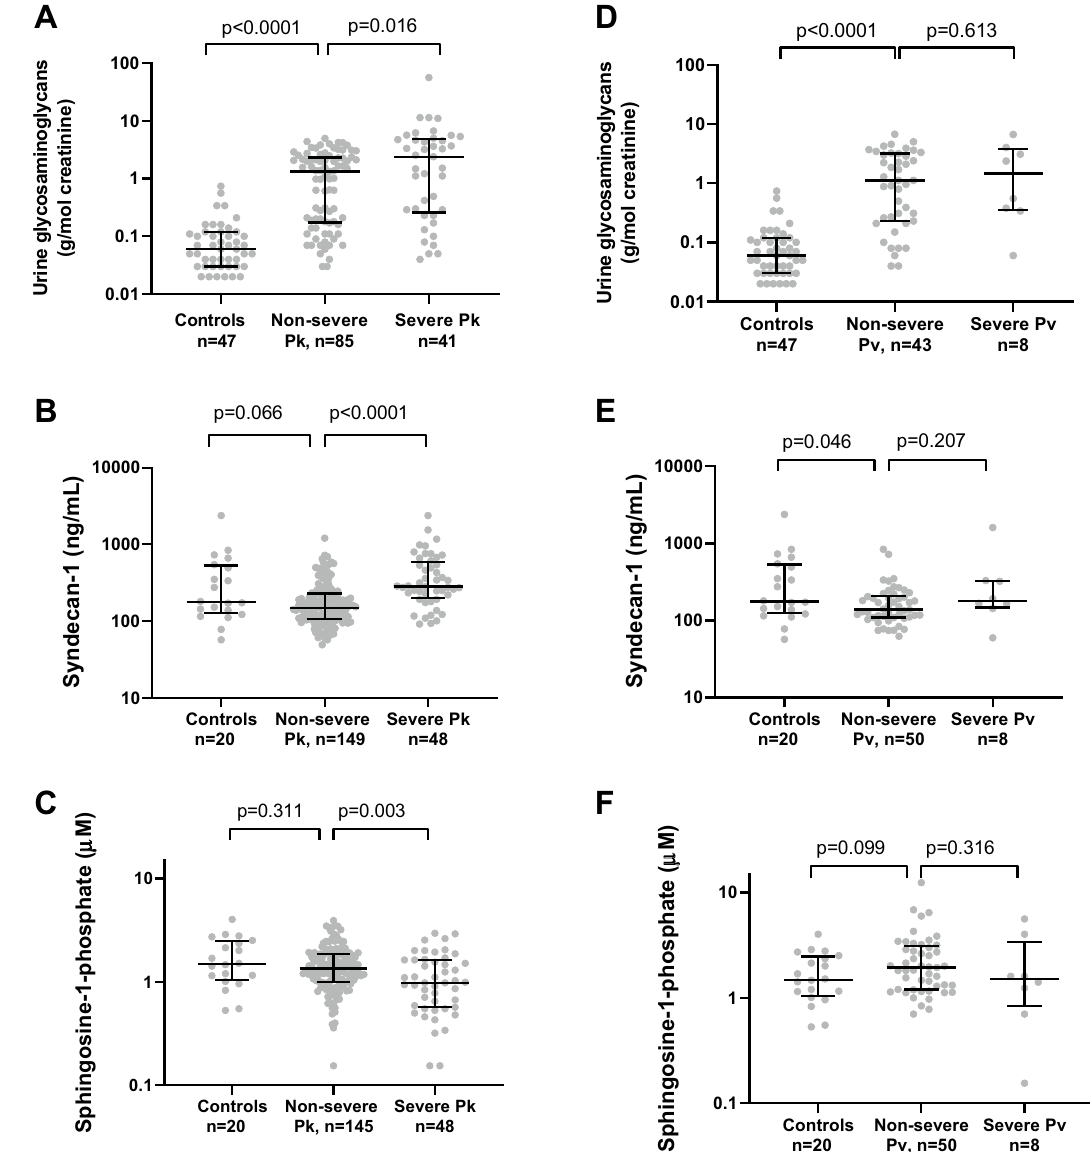
Figure 1. Glycocalyx breakdown products, and sphingosine-1-phosphate, in patients with knowlesi ( A – C ) and vivax ( D – F ) malaria, and in healthy controls. Errors bars indicate median and inter-quartile range. For comparisons between severe knowlesi malaria and controls, the P values are < 0.0001, 0.185, and 0.013 for panels ( A ), ( B ) and ( C ), respectively. For comparisons between severe knowlesi malaria and controls, the P values are < 0.001, 0.899, and 0.980, for panels ( D ), ( E ) and ( F ),